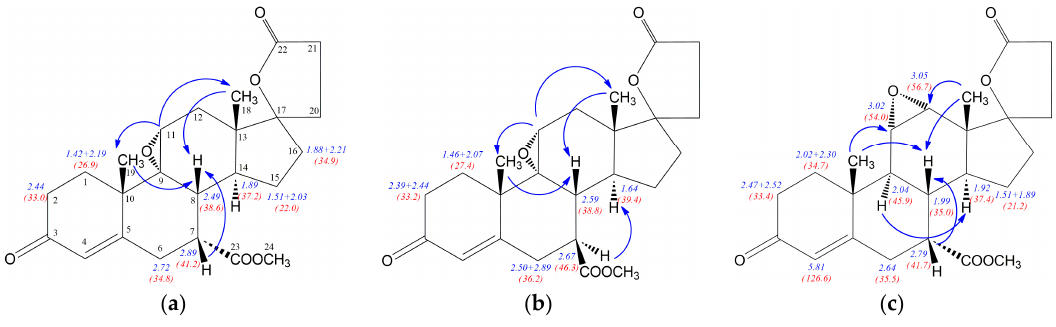
Figure 8. Crucial 1 H- and 13 C-NMR chemical shifts and NOE effects for: ( a ) (7 α ,11 α ,17 α )-9,11-epoxyester 2 ; ( b ) (7 β ,11 α ,17 α )-9,11-epoxyester 2a and ( c ) (7 α ,11 α ,12 α ,17 α )-11,12-epoxyester 2b .